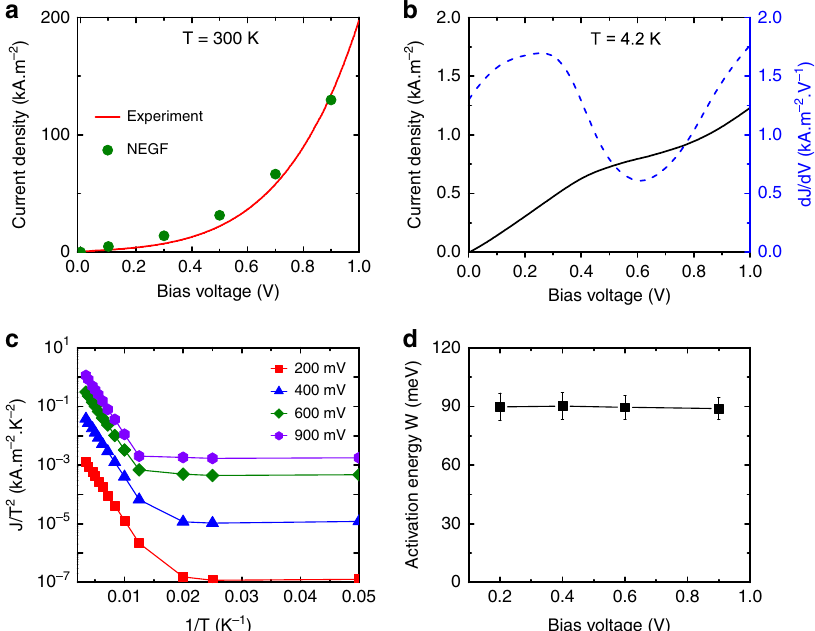
Fig. 2 Electron transport measurements. a Current density J measured as a function of the bias voltage V at 300 K (red solid line). The green symbols are the calculated current densities by NEGF simulations. b J – V curve measured at 4.2 K (black solid line). The resonant tunneling shoulder can be clearly identi fi ed at around V ∼ 0.5 V. The dotted curve shows the differential conductance curve, d I /d V . c log( J / T 2 ) is plotted as a function of 1/ T at various V . d Thermal activation energy, W , determined from the J – T data shown in ( c